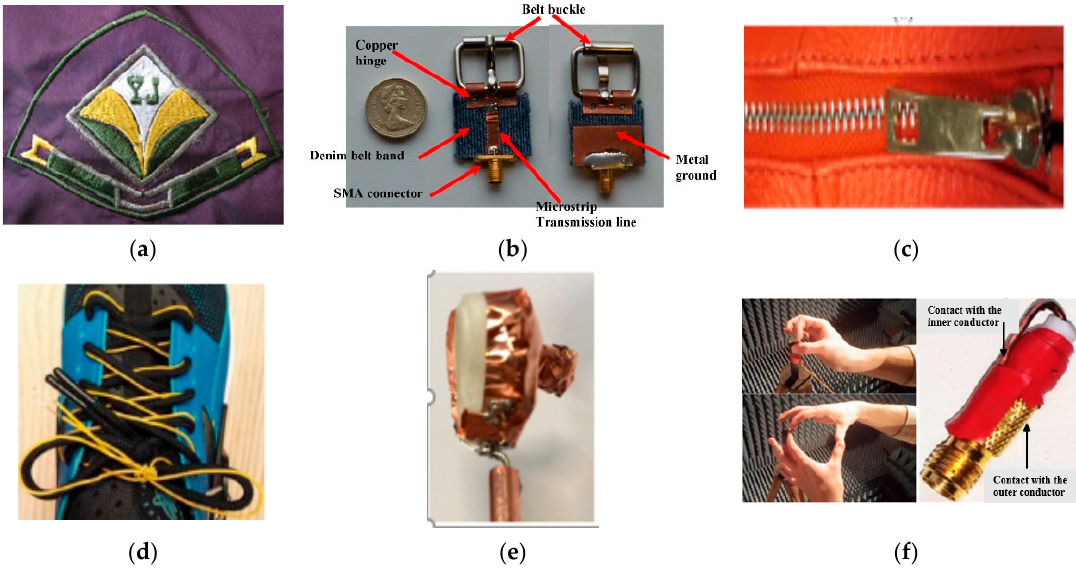
Figure 12. ( a ) Korean letters logo shape [322], ( b ) metallic belt antenna [323], ( c ) zip antenna [324], ( d ) shoelace antenna [325], ( e ) shell antenna [338], ( f ) human hand antenna (hantenna) [342].